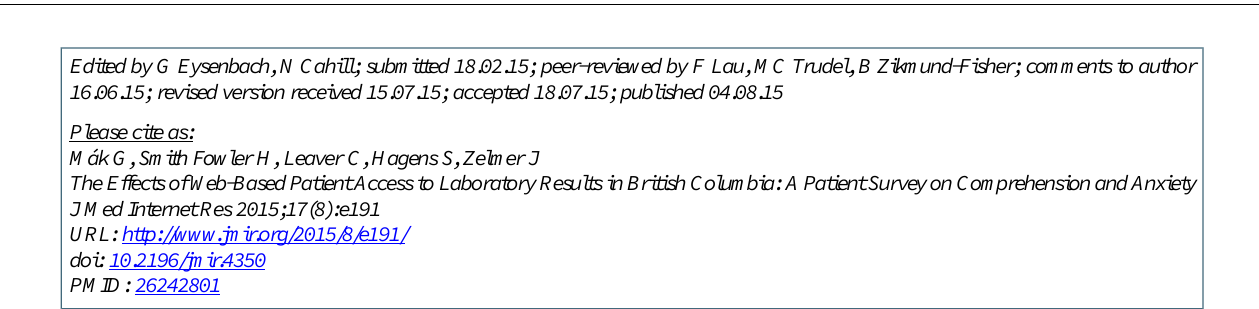
GA-VAS: Global Anxiety-Visual Analog